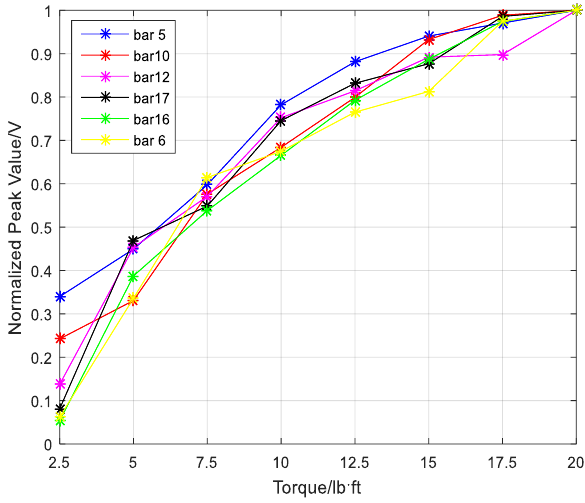
Sensors 2018 , 17 , x FOR PEER REVIEW Figure 13. The relationship between the peak value and torque levels on bar 5. Figure 13. The relationship between the peak value and torque levels on bar 5.